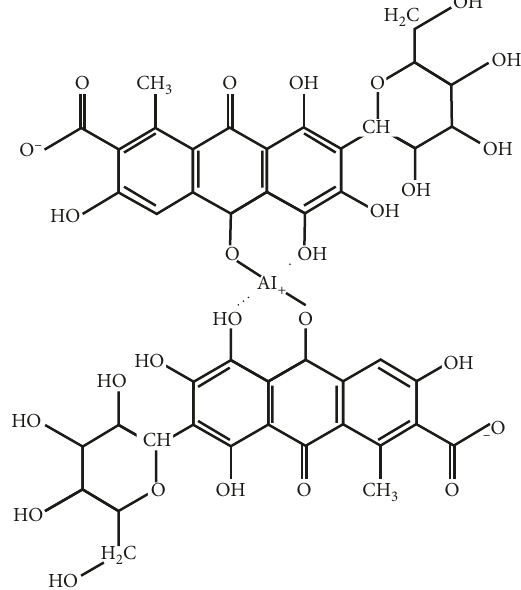
Figure 3: Molecular structure of